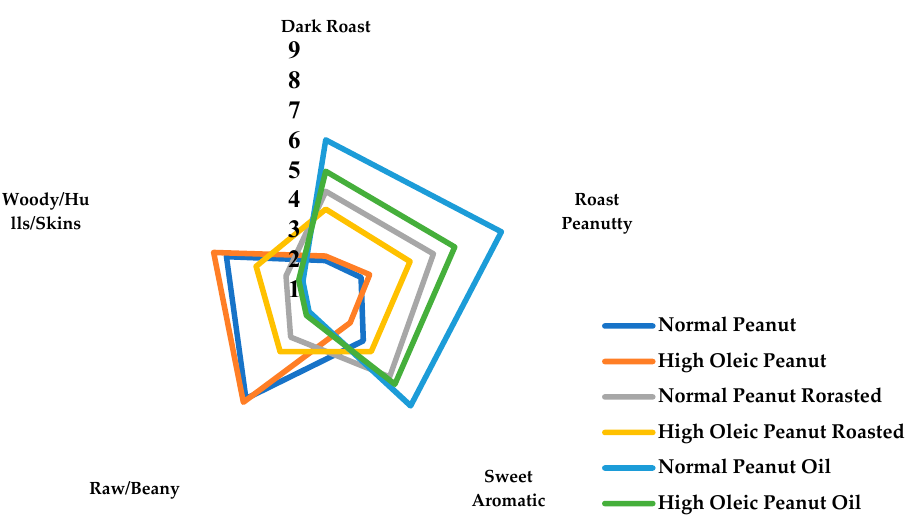
Figure 1. Sensory evaluation result of normal- and high-oleic peanut and oil processing samples.